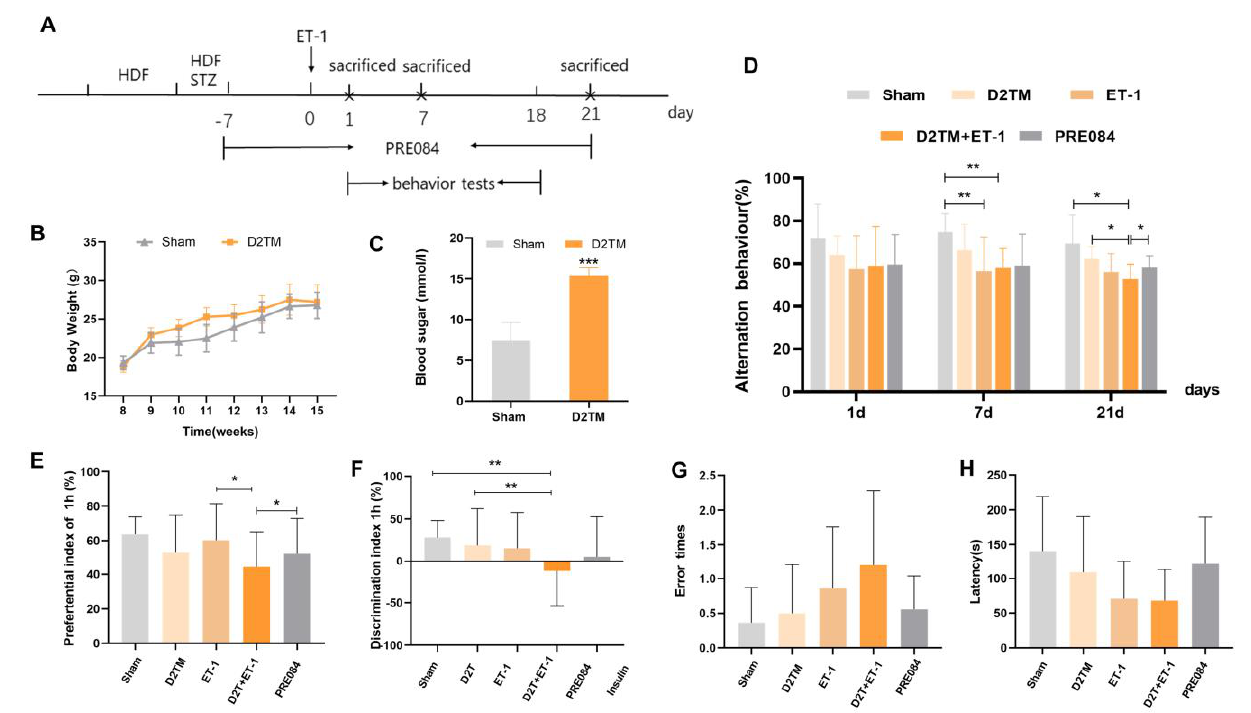
Figure 1. PRE084 improved long-term histological deficits and reversed cognitive dysfunction after stroke in diabetic mice. ( A ) The experimental design, PRE084, is a Sig1R agonist. ( B ) The body weights of the D2TM mice were higher than those of the sham mice. ( C ) The blood sugar levels of the D2TM mice were significantly higher than those of the sham mice. n = 60 – 70 in the sham group and n = 90 – 110 in the D2TM group, with *** p < 0.001 vs. sham. ( D ) Spatial working memory tests were evaluated using the Y-maze test. Alternation behavior was recorded after 1, 7, and 21 d of stroke. ( E – F ) Recall memory was evaluated via the novel object recognition test. Preferential and discrimination indices were recorded after 21 d of stroke. ( G – H ) Long-term memory was evaluated via the passive avoidance test. The error time and escape latency were recorded after 21 d of stroke.